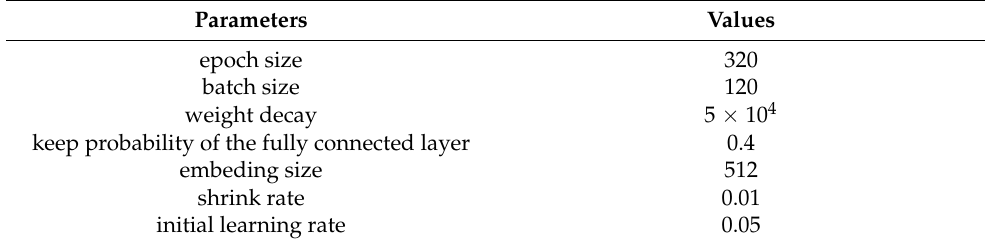
Table 3. Experimental simulation